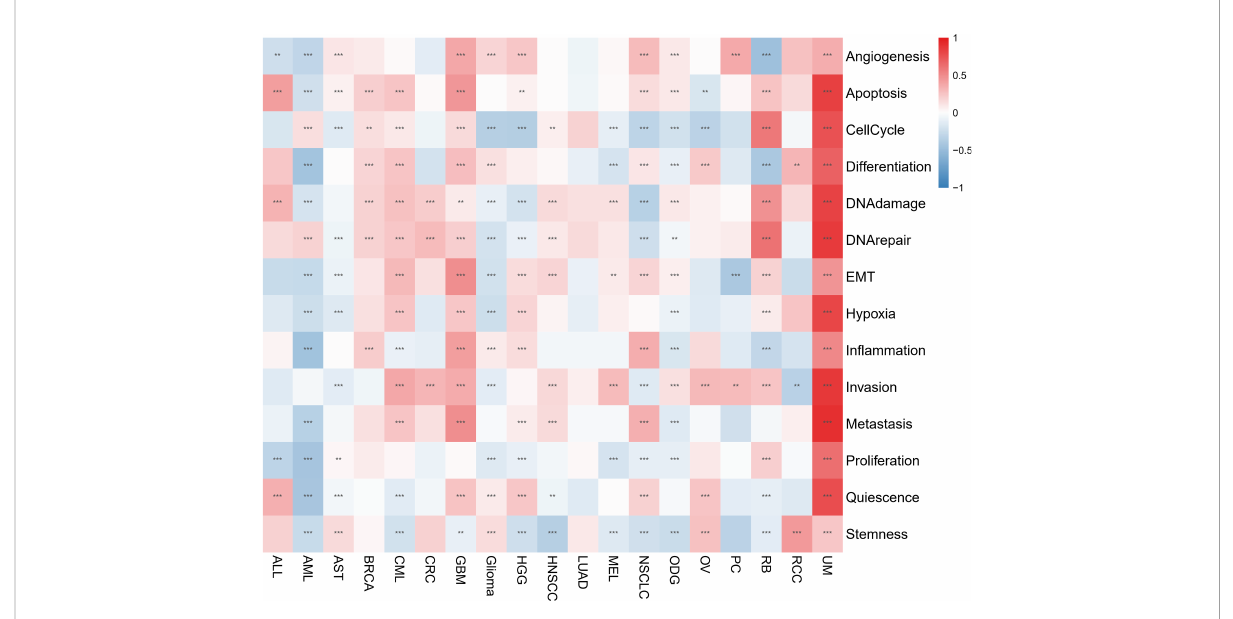
FIGURE 10 Migrasome scores are closely related to the cellular function of different cancer patients. Red represents positive correlations, while blue represents negative correlations. **P < 0.01, and ***P <